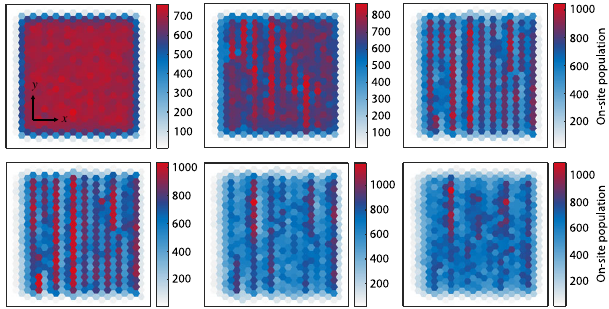
FIG. 5. Simulation of a homogeneously tilted lattice. Time series of the on-site populations for a BEC in a lattice with hard wall boundary conditions homogeneously tilted along the x direction. The hold times after initialization are 0, 10, 60, 100, 300, and 600 ms, from left to right and top to bottom. The dynamics are similar to that of the inhomogeneous system studied in the main text [Fig.